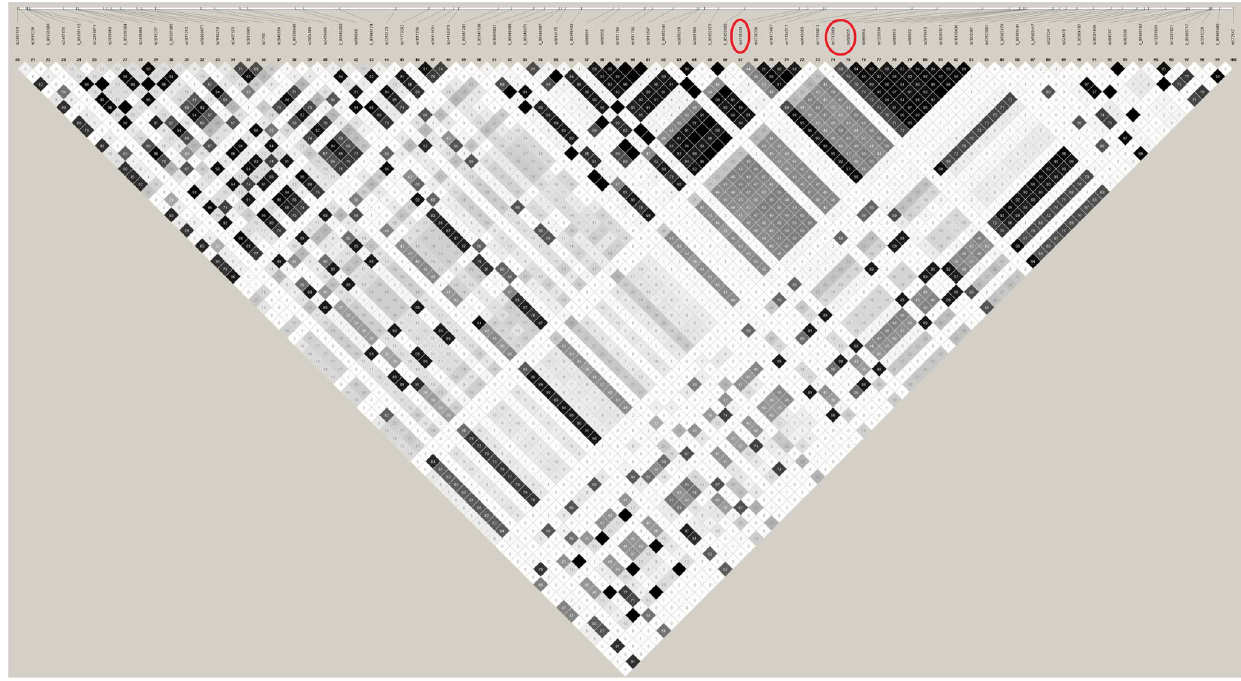
Figure 1. Linkage disequilibrium structure of TP53INP1 gene. The SNPs which are significant at 10 2 4 level are circled in red.